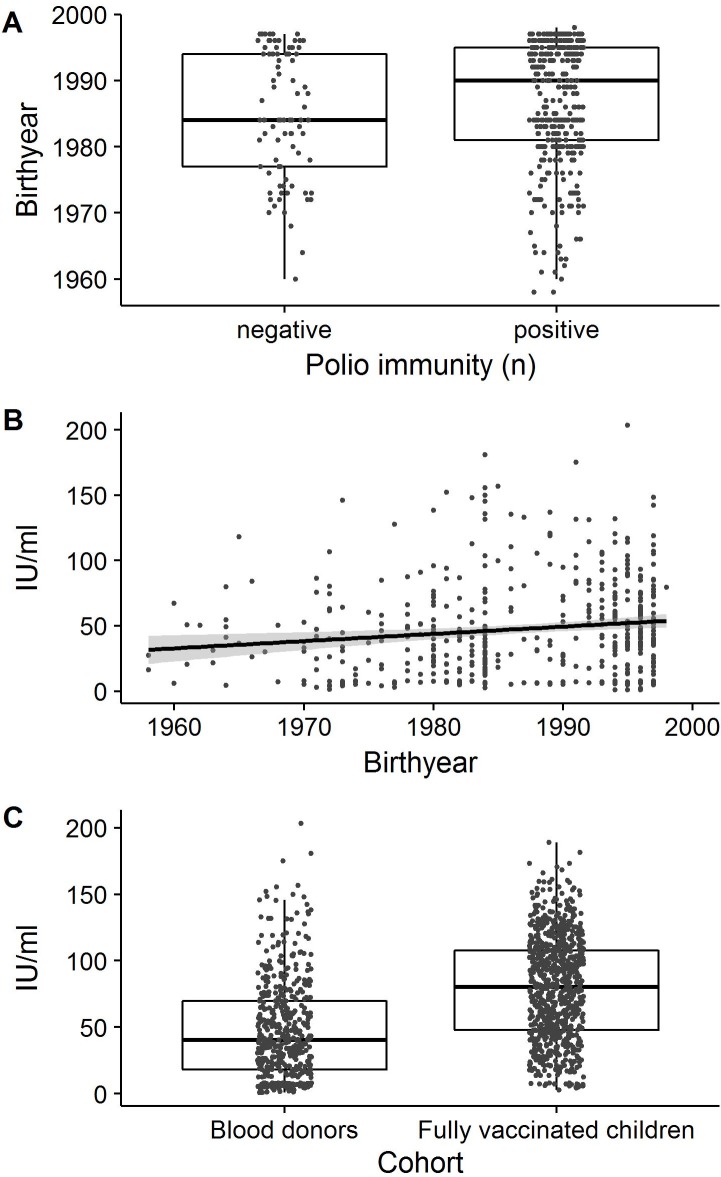
Age-related differences in poliovirus immunity as determined by ELISA.(A) Differences in age between seronegative and seropositive blood donors and (B) age-stratified anti- poliovirus antibody levels in blood donors. The regression line and the confidence interval (shaded) are shown. (C) Differences in median antibody levels between fully vaccinated children (Cohort 1) and blood donors (Cohort 4).